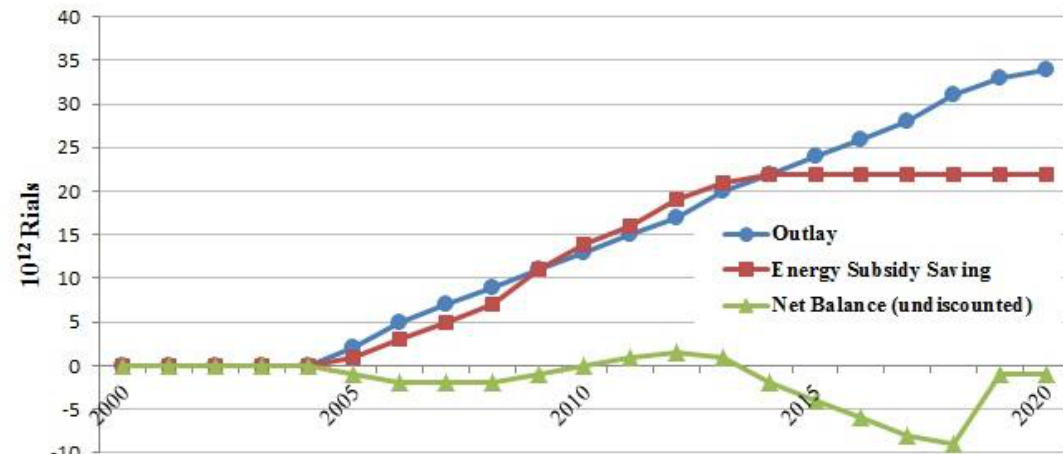
Figure 5. Net financial flows to the state